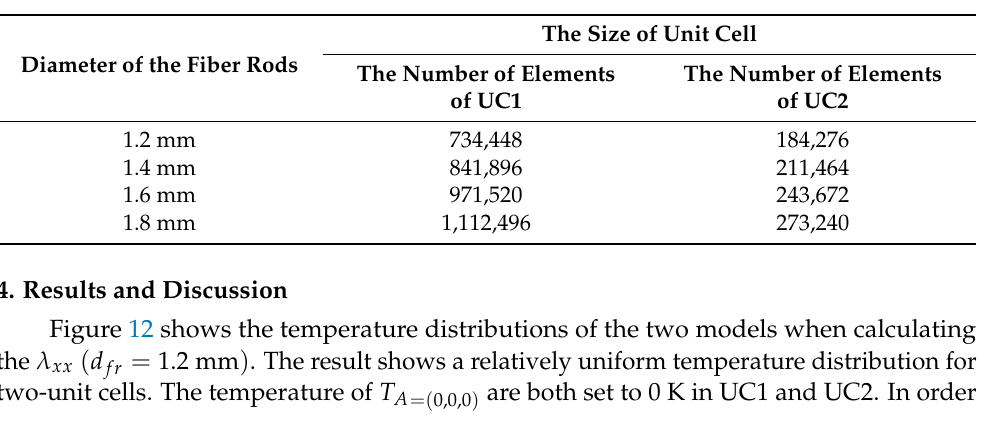
Figure 11. Meshed models of ( a ) UC1 and ( b ) UC2.